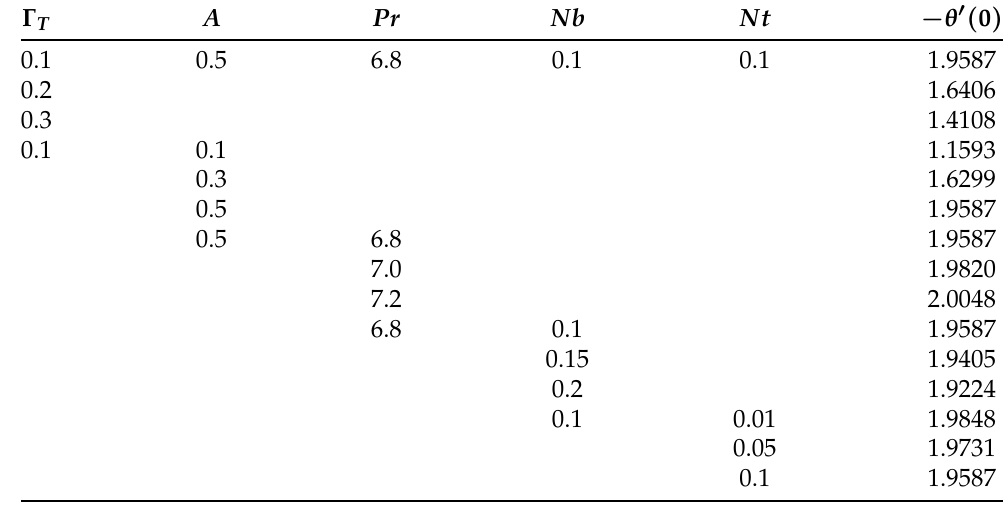
Table 4. Results for − θ (cid:48) ( 0 ) .